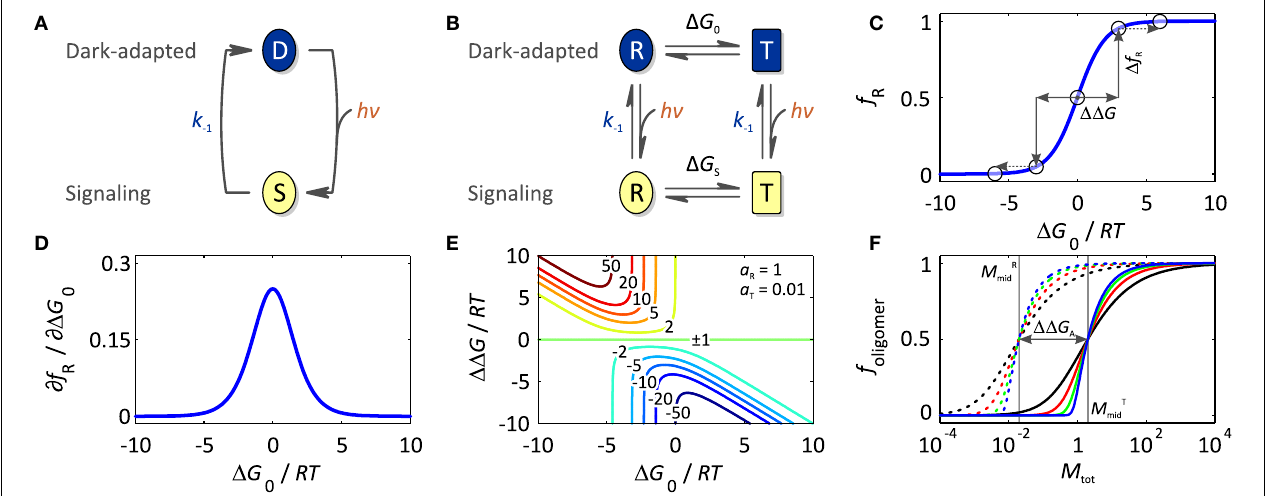
positive values of 11 G increase f R , and negative values of 11 G decrease f R . (D) f R is maximally sensitive to free energy perturbations near 1 G 0 0 = but essentially invariant if | 1 G 0 | >> 0. (E) The dynamic range d for the signal response, i.e., the ratio of the biological activities in the absence and presence of signal, depends on the initial equilibrium between R and T ( 1 G 0 ), the magnitude of the perturbation ( 11 G ), and the intrinsic activities of R and T, a R and a T . Contour lines denote the magnitude of d for the parameter set a R 1 and a T 0 . 01 , where positive values of d refer to = = light-activated and negative values to light-repressed photoreceptors. (F) Isotherms for homo-association of photoreceptors where f oligomer denotes the protein fraction in oligomeric form and M tot the total monomer concentration. Black, red, green and blue curves refer to dimeric, trimeric, pentameric and decameric complexes, respectively, bold lines correspond to the low-affinity T state and dashed lines to the high-affinity R state. For photoassociating systems, 11 G A is positive, and light promotes a transition from the low-affinity (solid) to the high-affinity (dashed) isotherms. Vice versa , for photodissociating systems, 11 G A is negative, and light promotes a transition from high-affinity to low-affinity